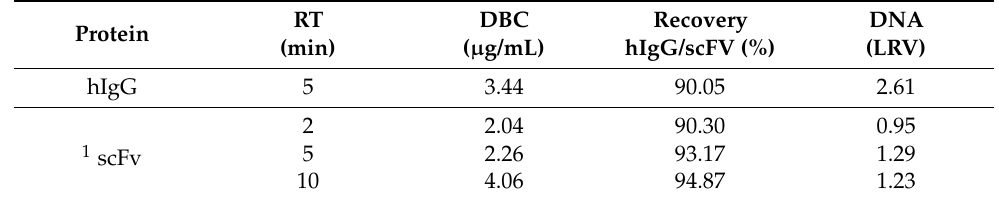
Figure 8. Removal of DNA from hIgG ( a ) and scFv ( b ) protein solution using anion-exchange PBT-GMA-DEA membrane operated in flow-through mode. The target proteins are collected in the flow through fraction and DNA in the elution peak. The insets show higher magnification of eluted DNA peak. Table 5. DNA clearance and protein recovery using nonwoven anion-exchange PBT-GMA-DEA membranes.